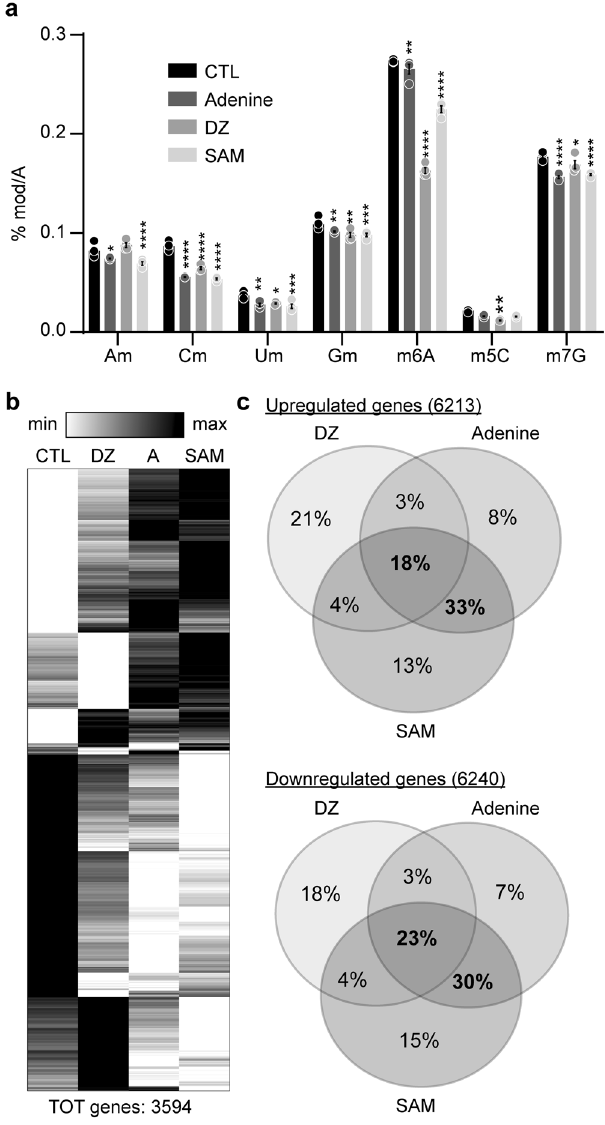
Fig. 5 Adenine and SAM inhibit mRNA methylation and have similar transcriptome signature. a Quanti fi cation of methylated nucleotides in mRNA from cells treated with DZ, adenine, or SAM. Am, Cm, Um, and Gm correspond to 2 ’ - O -ribose methylation of A, C, U, and G, respectively; m6A is N 6 -methyladenosine; m5C is 5-methylcytosine; m7G is N 7 -methylguanine. Data show mean + / − S.E.M. of n = 4 cell culture wells, analyzed by two-way ANOVA (all sources of variations p <0.0001) followed by Bonferroni multiple comparison test, * p <0.05, ** p <0.01, *** p <0.001, **** p <0.0001. b Heatmap representation of 3594 genes signi fi cantly regulated by DZ (10 μ M), adenine (1mM), and SAM (1mM), based on the mean of 3 replicate dishes. c Venn diagrams showing the overlap in signi fi cantly up- (6213) and downregulated (6240) genes between cells treated with DZ (10 μ M), adenine (1mM), or SAM (1mM). See also Supplementary Data